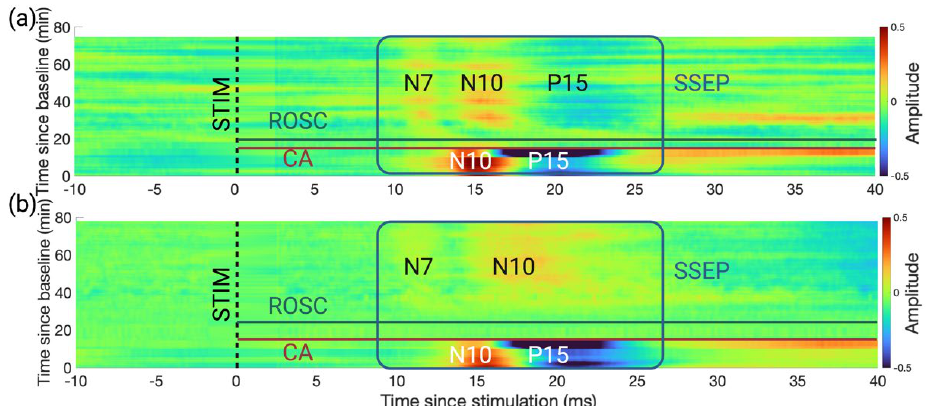
Figure 3. SSEP did not recover to the original waveform 60 min post-ROSC. ( a ) Evolution of SSEPs for group CA3 ( n = 5 subjects). The x -axis spans from 10 ms before stimulation to 40 ms after stimulation. Each row represents one averaged SSEP waveform of 100 trials, and a twenty-second gap exists between subsequent rows. The y -axis spans from 0 min to 80 min since baseline. The onsets of CA and ROSC are highlighted with a red and a green line. The SSEP components are highlighted within the blue box. The N10 and P15 peak components were present before CA. During recovery, the N10 peak separated into two peaks, N7 and N10, and the P15 peak was preserved. ( b ) Evolution of SSEPs for group CA7 ( n = 6 subjects) of CA. N10 separated into two peaks, N7 and N10, and the P15 peak was not preserved. Created with Biorender.com.